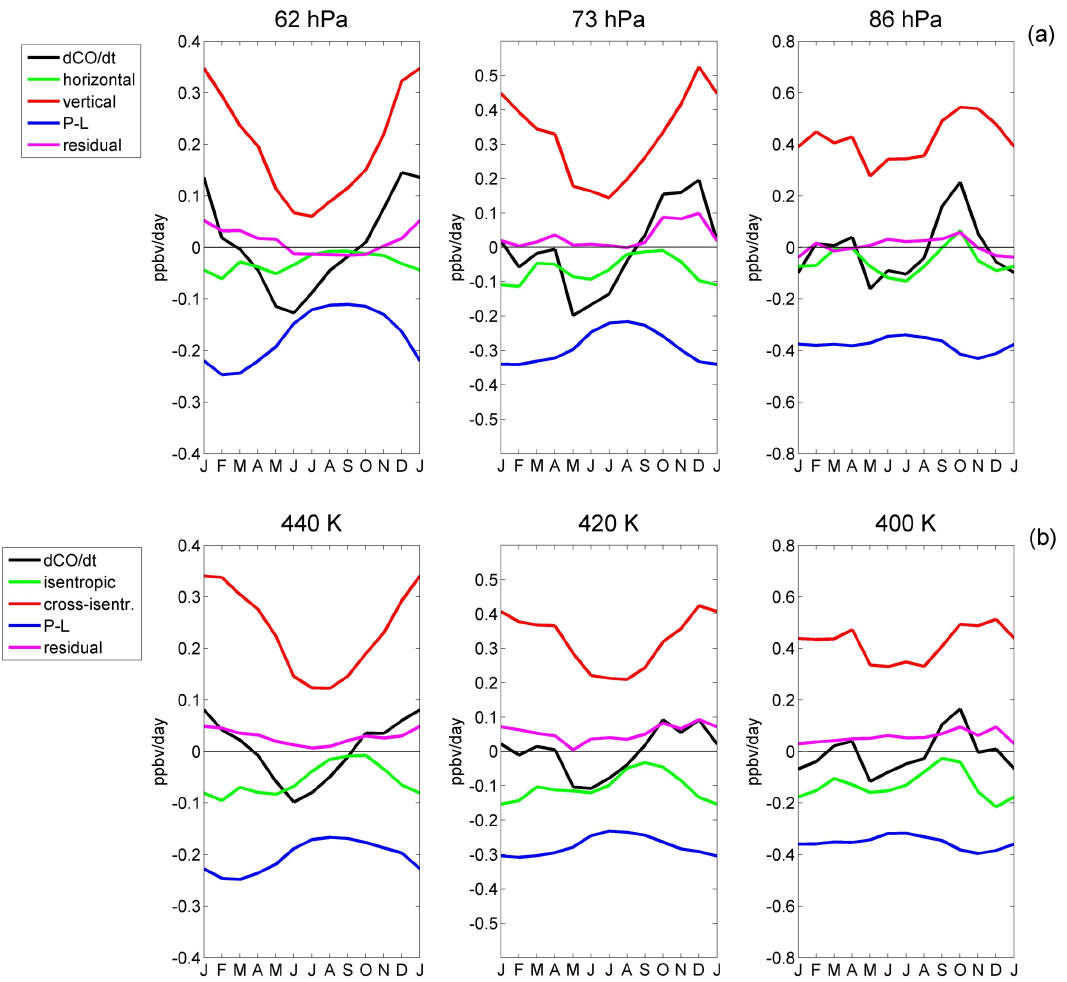
Fig. 12. Mean seasonal cycle (monthly means) of the terms in the CO continuity equation averaged over 18 ◦ S–18 ◦ N on pressure levels (Eq. 5, a ) and isentropic levels (Eq. 6, b